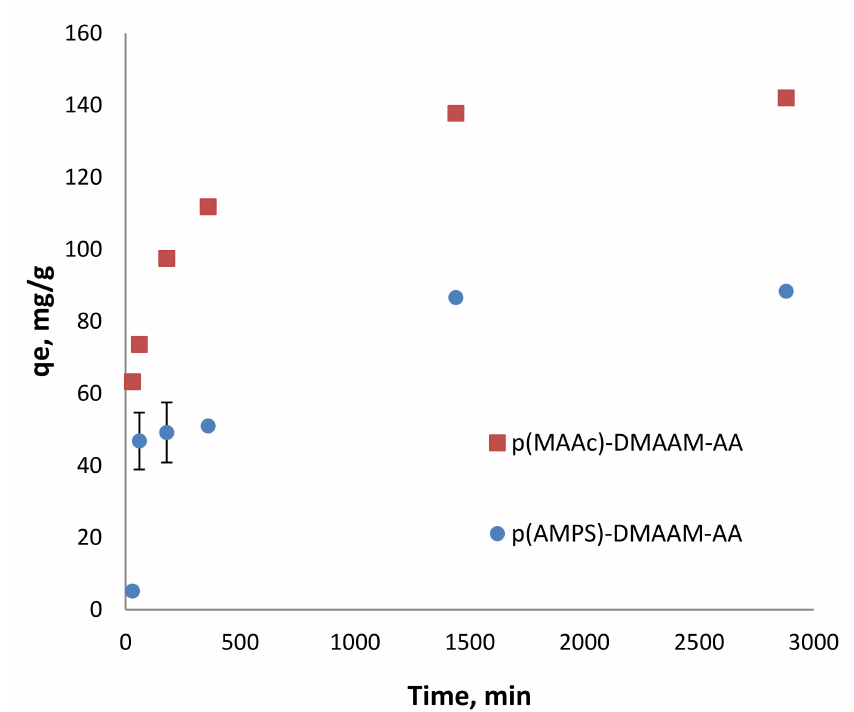
Figure 3. Cd 2 + removal kinetics on the p(MAAc)-DMAAm-AA and p(AMPS)-DMAAM-AA cryogels (70 mg of cryogel in 100 mL of solution) at pH